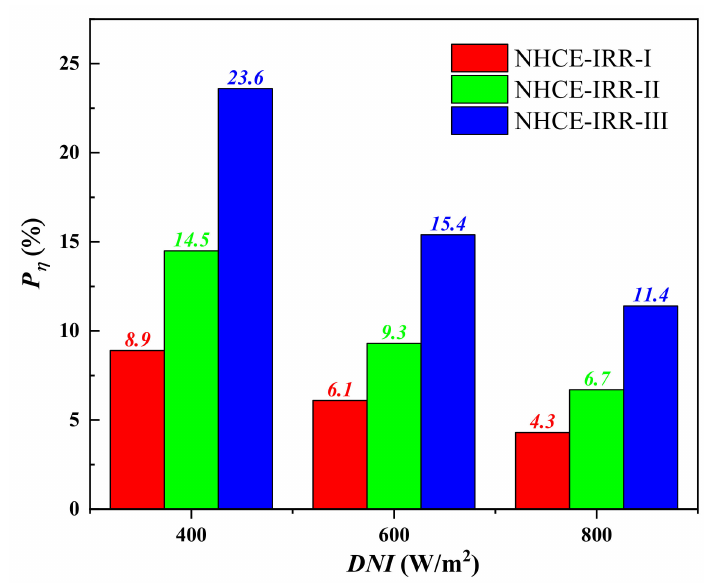
Figure 12. Percentage of energetic e ffi ciency enhancement of NHCEs versus DNI.